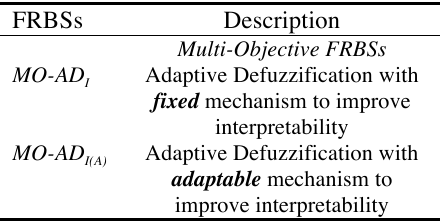
Table 8. FRBSs considered for comparison FRBSs